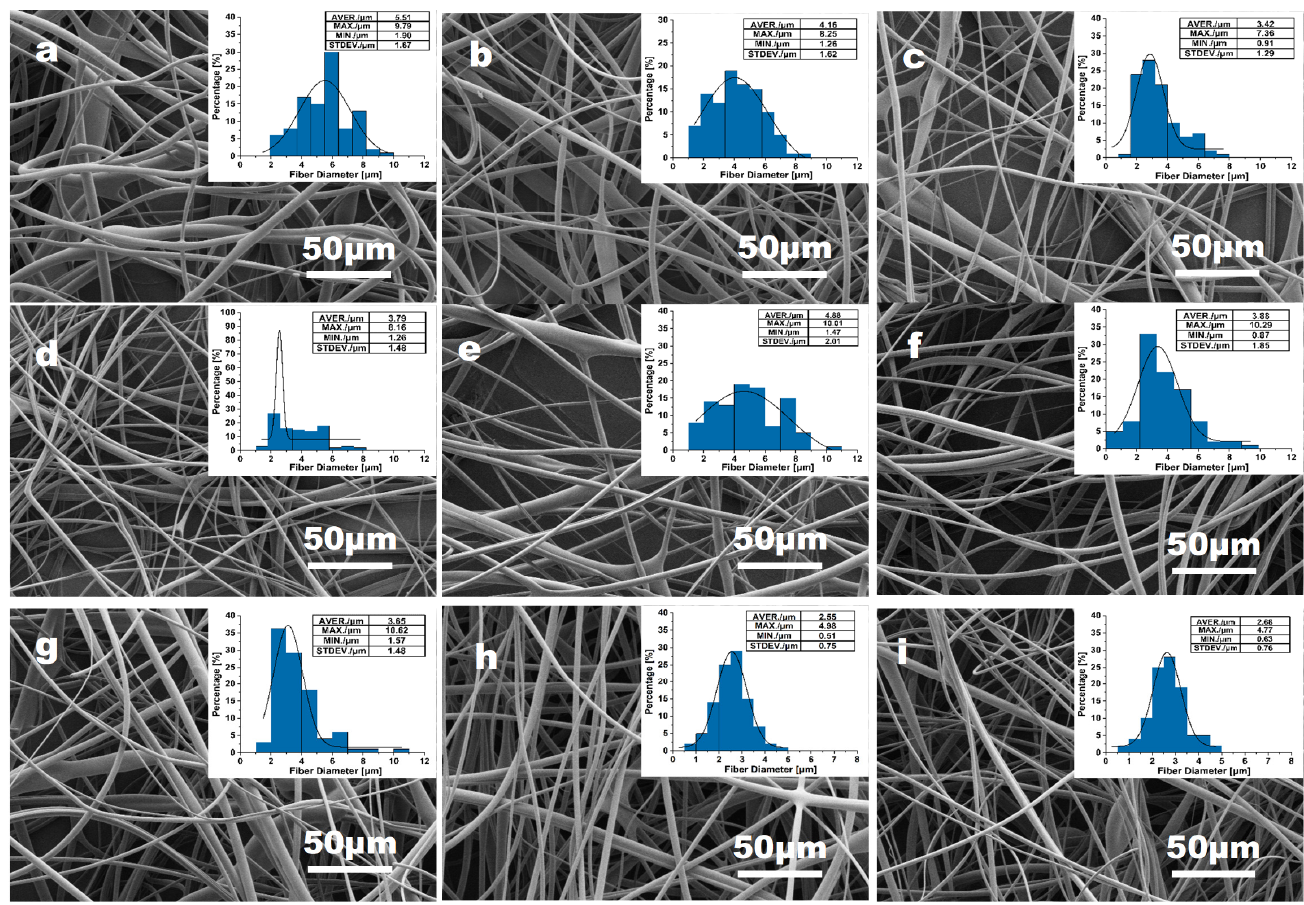
Figure 11. PVA fibers obtained from the orthogonal experiment of ( a ) experiment No. 1; ( b ) experiment No. 2; ( c ) experiment No. 3; ( d ) experiment No. 4, ( e ) experiment No. 5, ( f ) experiment No. 6; ( g ) experiment No. 7; ( h ) experiment No. 8; ( i ) experiment No. 9. Table 3. Orthogonal test analysis on the average diameter of ECS fibers.